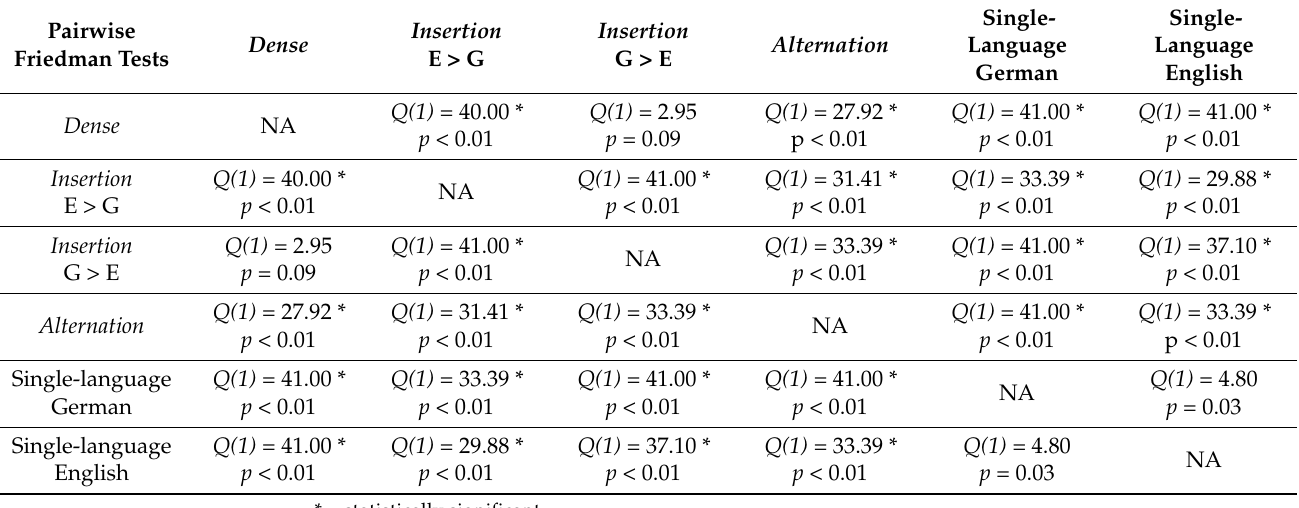
Table 4. Pairwise comparisons frequency judgement task.